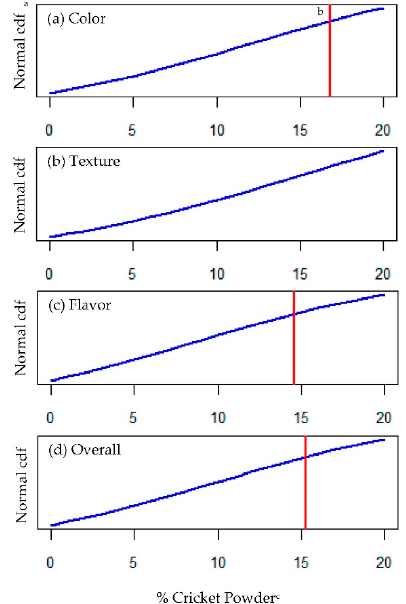
Figure 4. Rejection tolerance threshold 25% (RTT 25 ) for cricket powder in whole-wheat snack crackers. Thresholds were measured for ( a ) color, ( b ) texture, ( c ) flavor and ( d ) overall acceptance using probit regression, based on 25% rejection tolerance, where the cumulative left-tail probability = 0.25 (represented by an area under blue line). a Normal cumulative distribution functions (cdf) were based on probit regression models, where the left-tail area under blue line represents the estimated probability of rejection (acceptability = “no”) as a function of % cricket powder. b Red vertical line represents the RTT 25 as the predicted % cricket powder associated with 25% rejection (acceptability = “no”) from probit models (not found for texture). c Percentage of cricket powder used in place of whole-wheat flour ( w/w ) in cracker formulations.